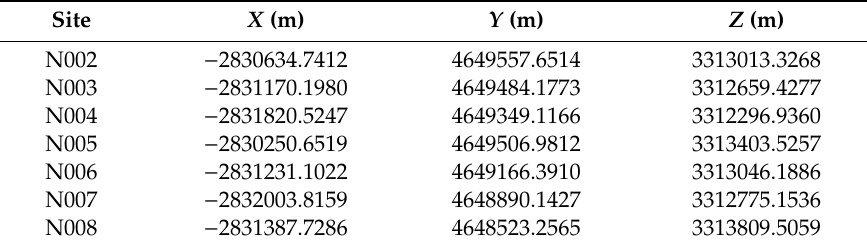
Table A2. Approximate coordinates of the solved-for